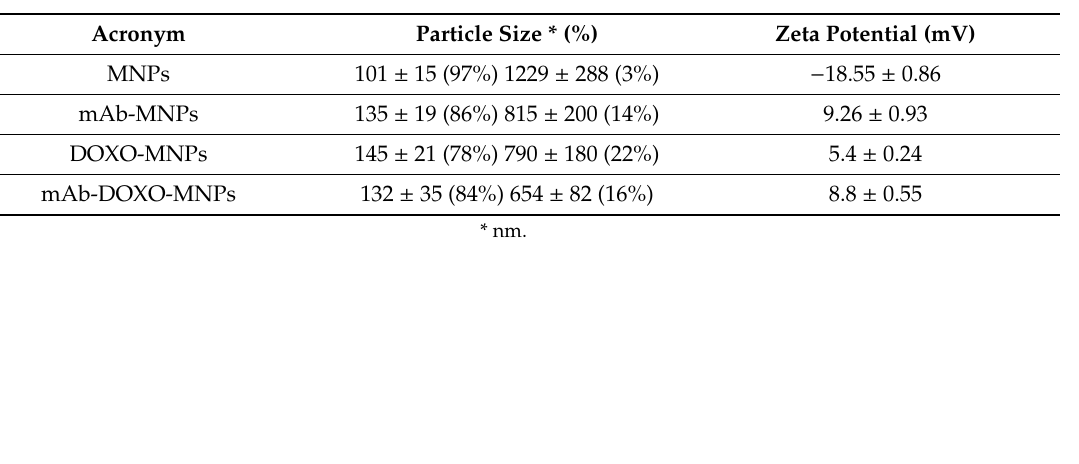
Table 1. Properties of magnetic nanoparticles